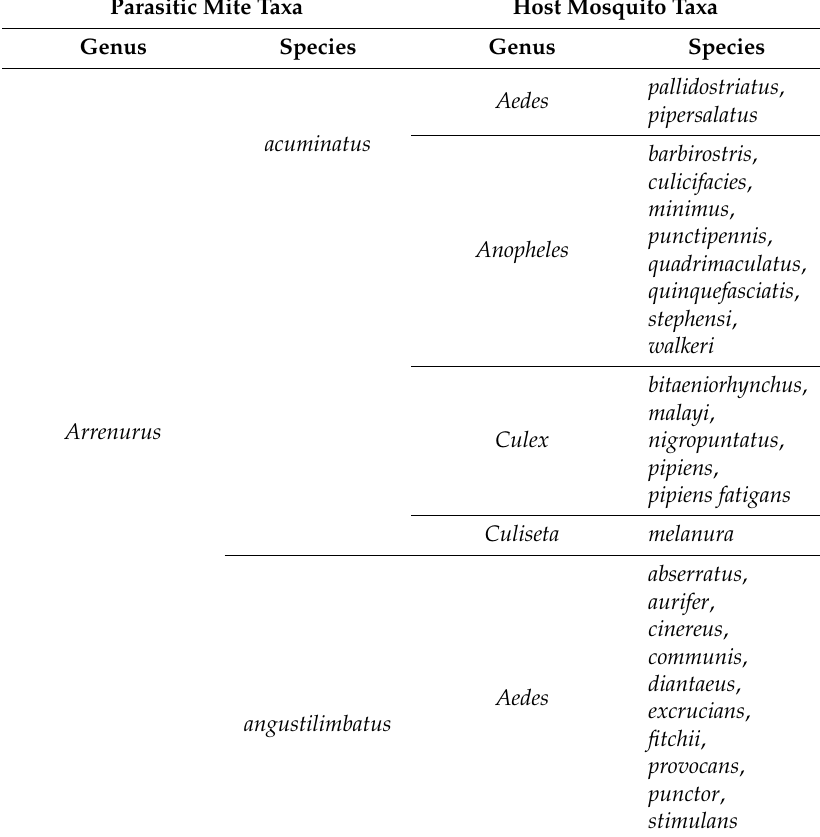
Table A1. Arrenurus water mite species and the mosquito species they parasitize